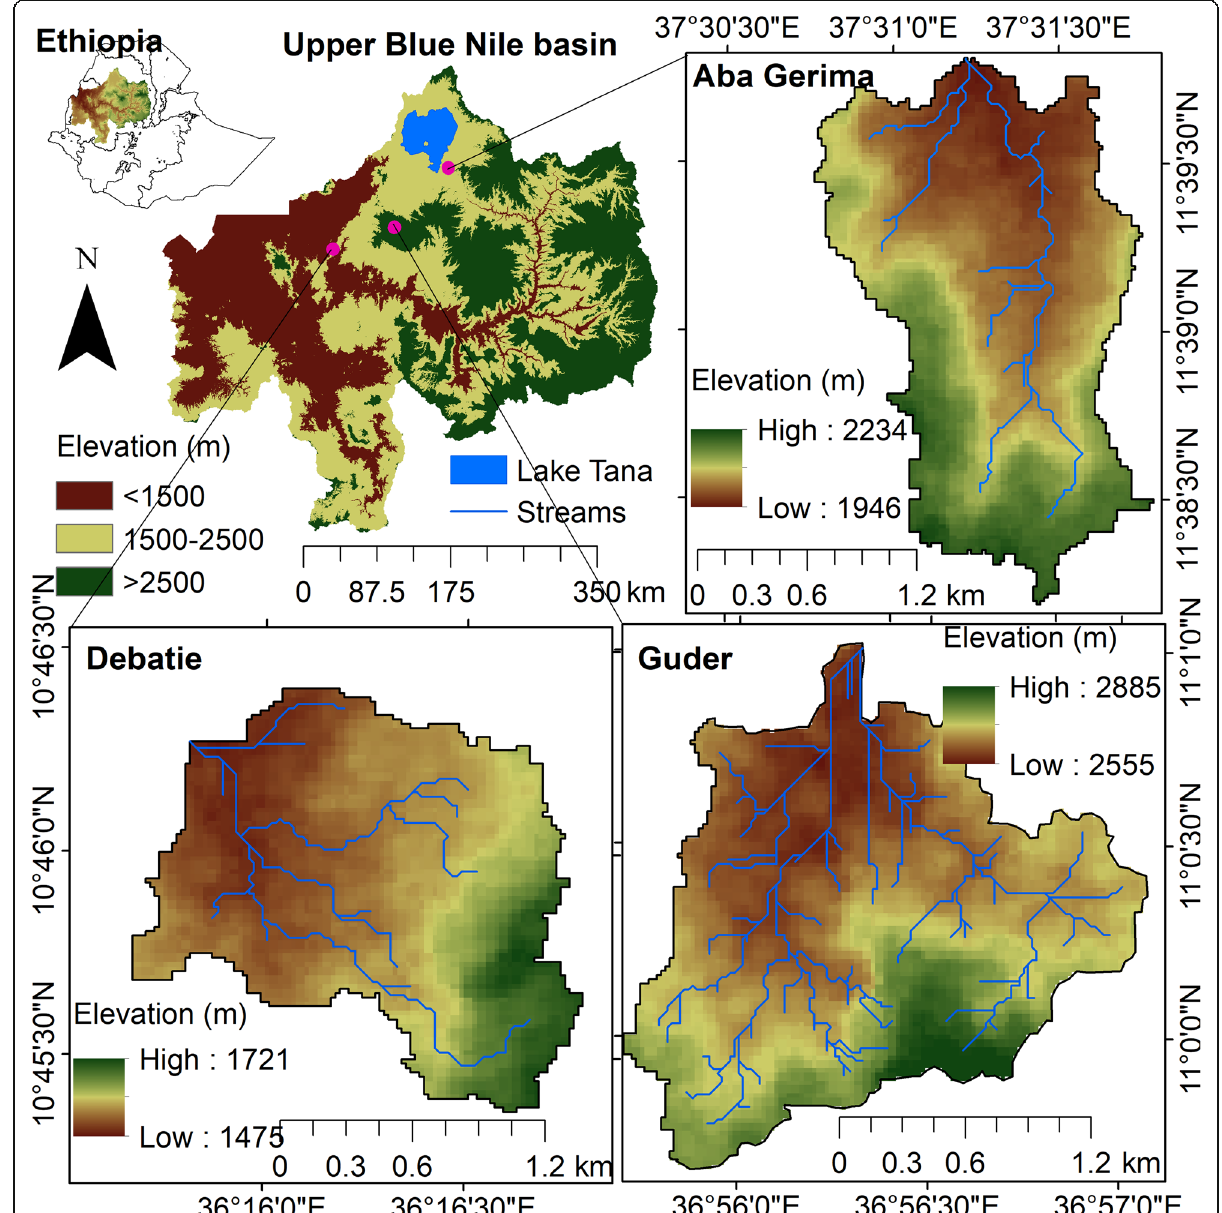
Fig. 1 Location and elevation maps of Guder, Aba Gerima, and Debatie watersheds (adapted from Berihun et al.